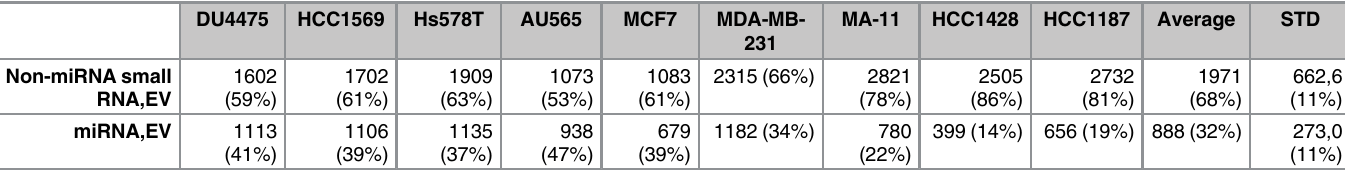
Table 1. Number of unique non-miRNA small RNAs and miRNAs (tags) detected in the nine breast cancer